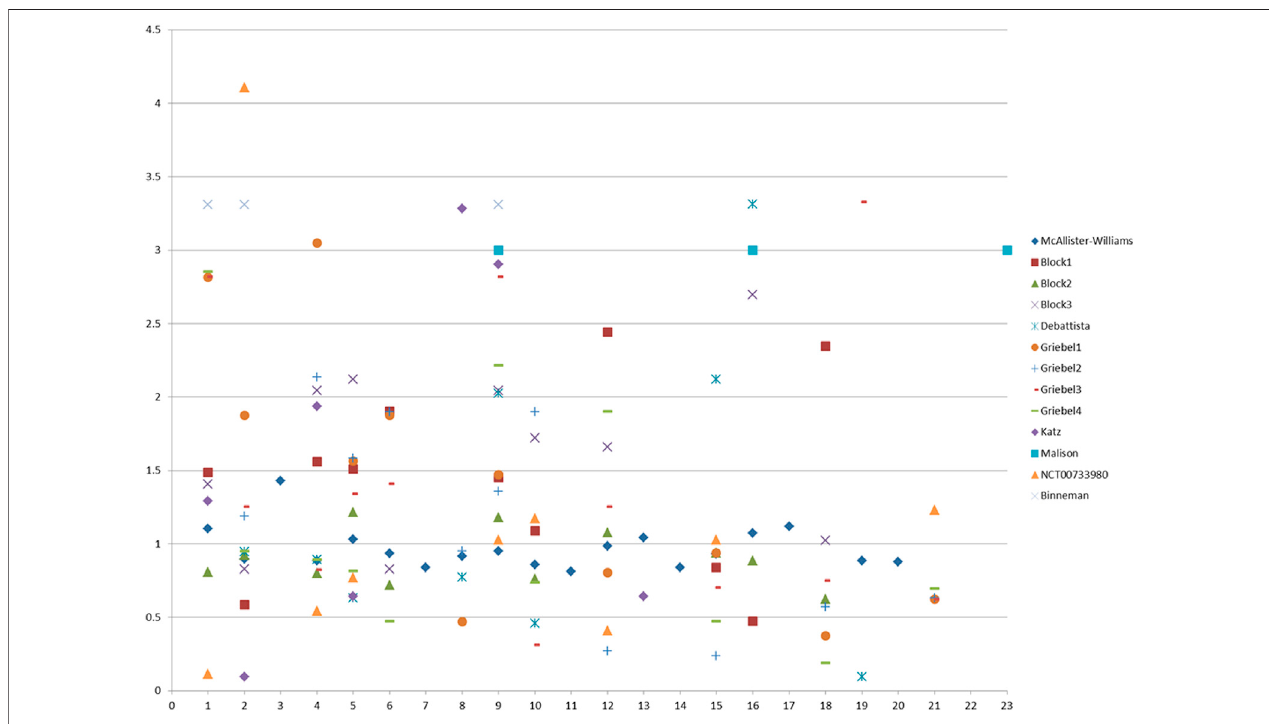
FIGURE 3 | Scatter plot of the RRs of 23 side effects of HPA-targeting medications reported by eight included RCTs. RR, risk ratio.